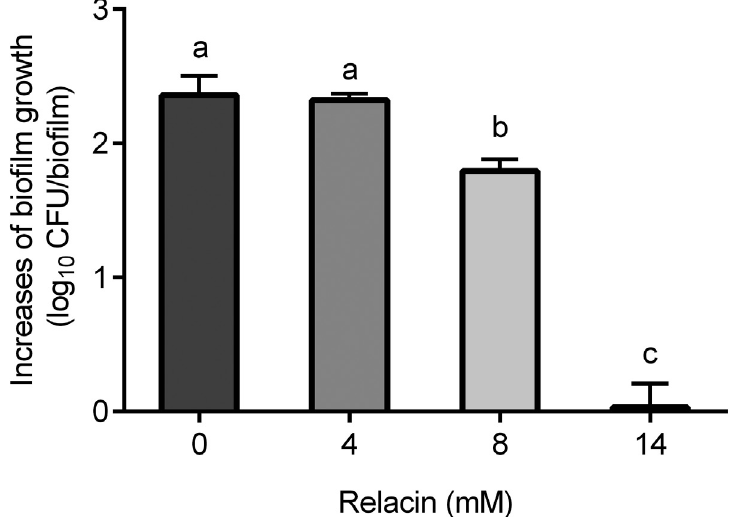
Figure 1- Growth inhibition of E. faecalis OG1RF biofilms by relacin treatments for 24 h. The biofilm growth was presented as the log CFU increase in each biofilm sample. Different lowercase letters indicate significant difference (p<0.05)